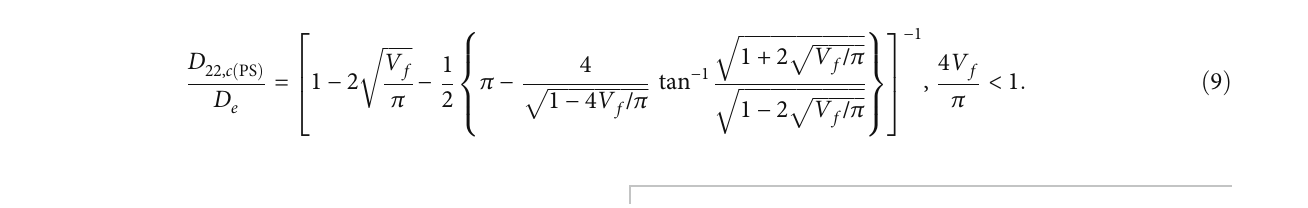
4 ffiffiffiffiffiffiffiffiffiffiffiffiffiffiffiffiffiffiffiffi